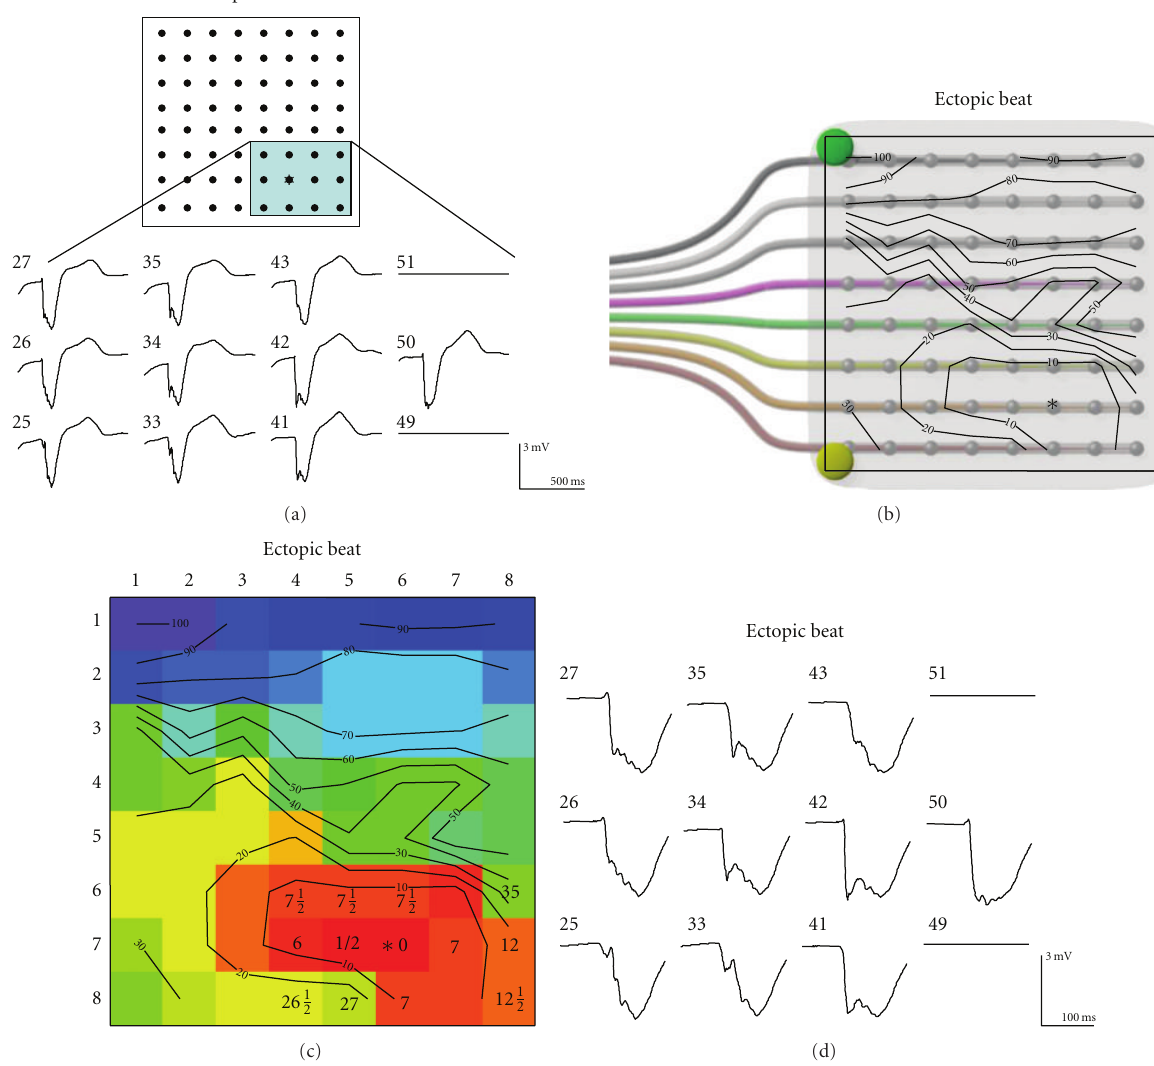
Figure 3: Multielectrode high density mapping was performed using a rectangular grid electrode harboring 64 electrode terminals arranged in an 8 × 8 matrix (interelectrode distance 5mm). The electrode was positioned over the area where the origin of the tachycardia was expected. The earliest site of epicardial activation was located at the apicolateral side of the left ventricle. The numbers on the left side of the unipolar electrograms refer to the grid electrodes (a). The unipolar electrogram recorded at the earliest activated site was initially negative, suggesting that activation spread from this site. Isochronal maps depict the centrifugal activation pattern of the ectopic beats (b and c). Electrograms at sites adjacent to the earliest activated site were fractionated, suggesting discontinuous conduction (d). See text for